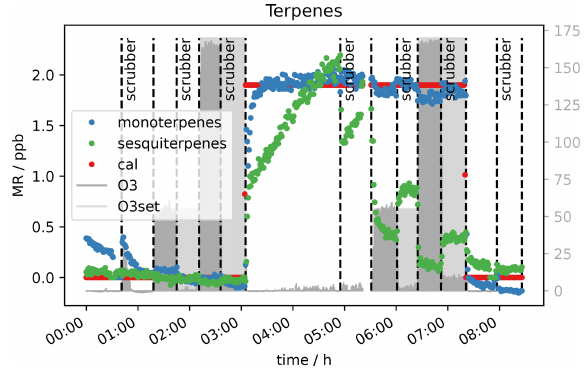
Figure 10. Terpene mixing ratios measured by PTR-MS with and without scrubber at 50 and 170ppb O 3